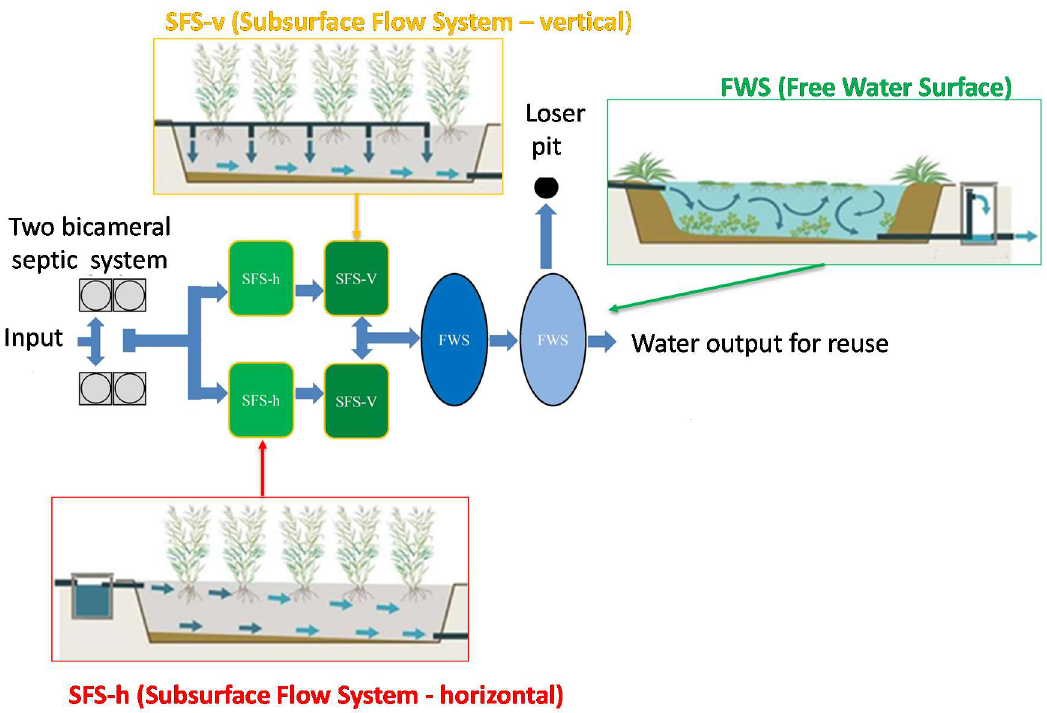
Figure 5. Synthetic scheme of the hypothesised hybrid constructed treatment wetland (CTW; modified from and inspired by [84,91–93]). Loser pit refers to a sink of water from extreme events.